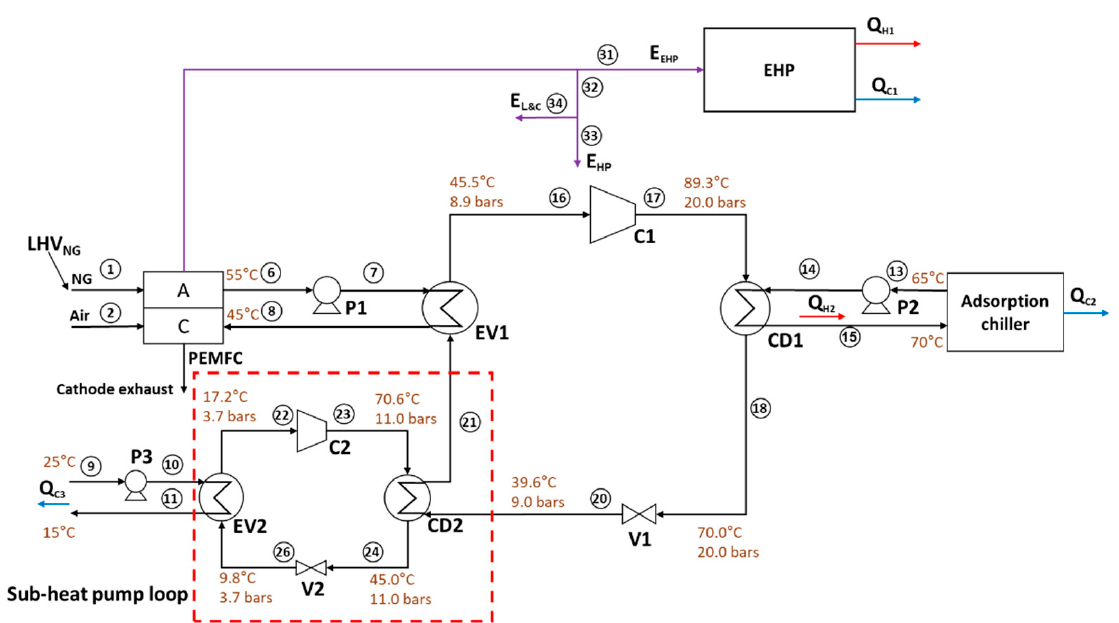
Figure 3. Proposed layout with a cascade heat pump loop (case B).